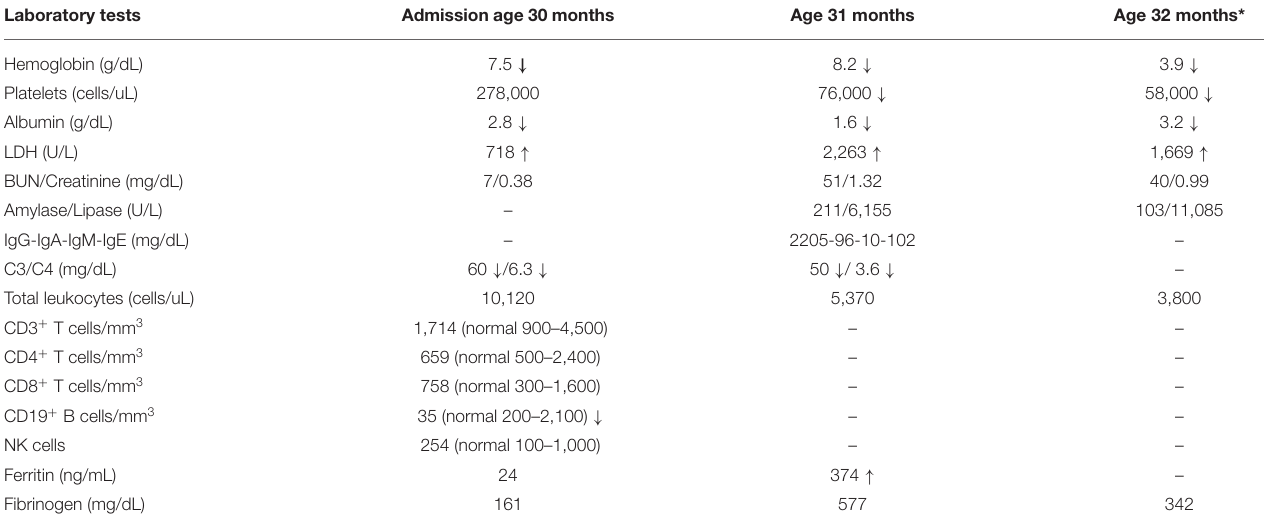
TABLE 1 | Patient’s laboratory testing.